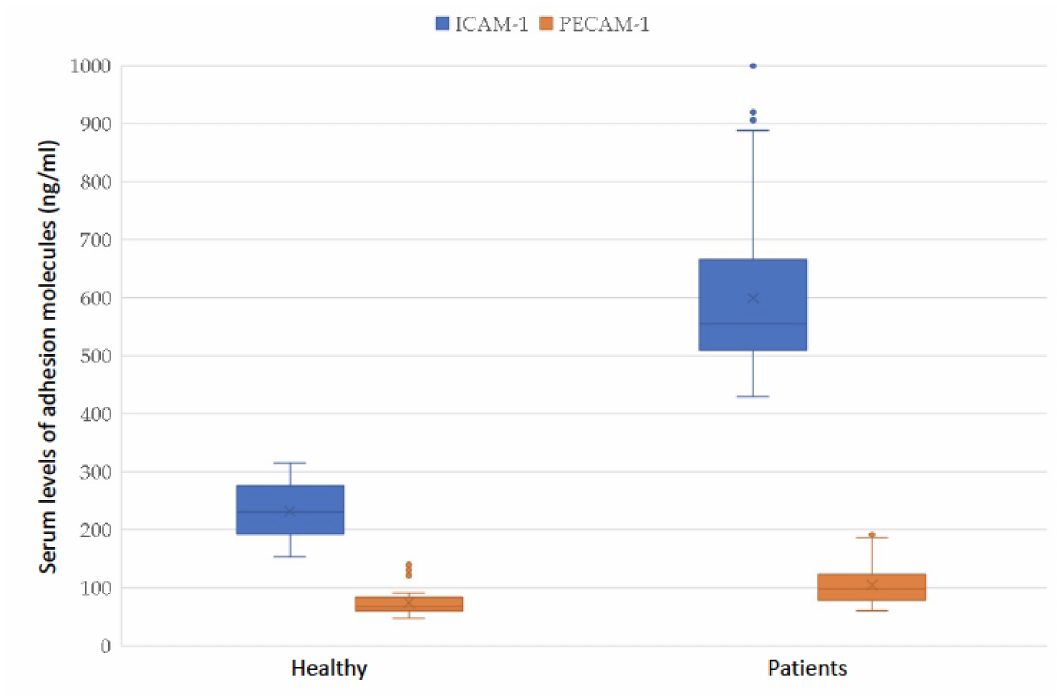
Figure 1. Adhesion molecules PECAM-1 and ICAM-1 in the serum of patients after breast cancer treatment and healthy volunteers. Table 5. Adhesion molecules PECAM-1 and ICAM-1 in the serum of